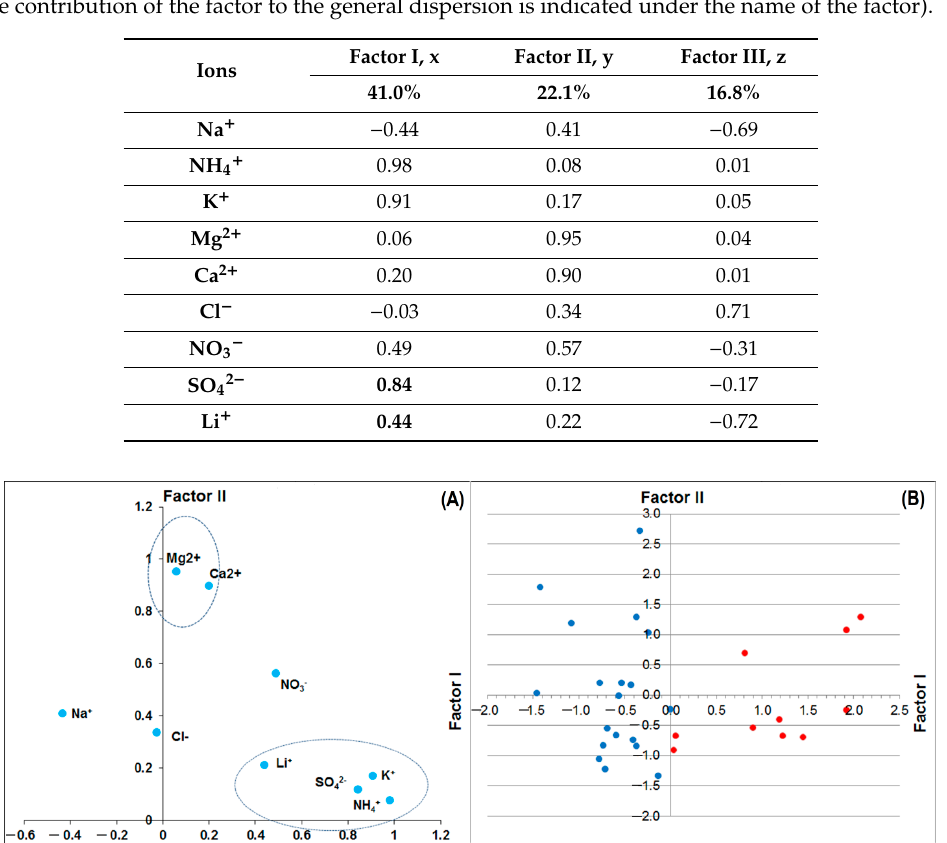
Table 9. Factor loads of the analyzed ions in the soluble part of aerosol in the near-water atmospheric layer of Lake Baikal along the route of the RV “Akademik V.A. Koptyug” from 24 July to 4 August 2019 (the contribution of the factor to the general dispersion is indicated under the name of the factor).